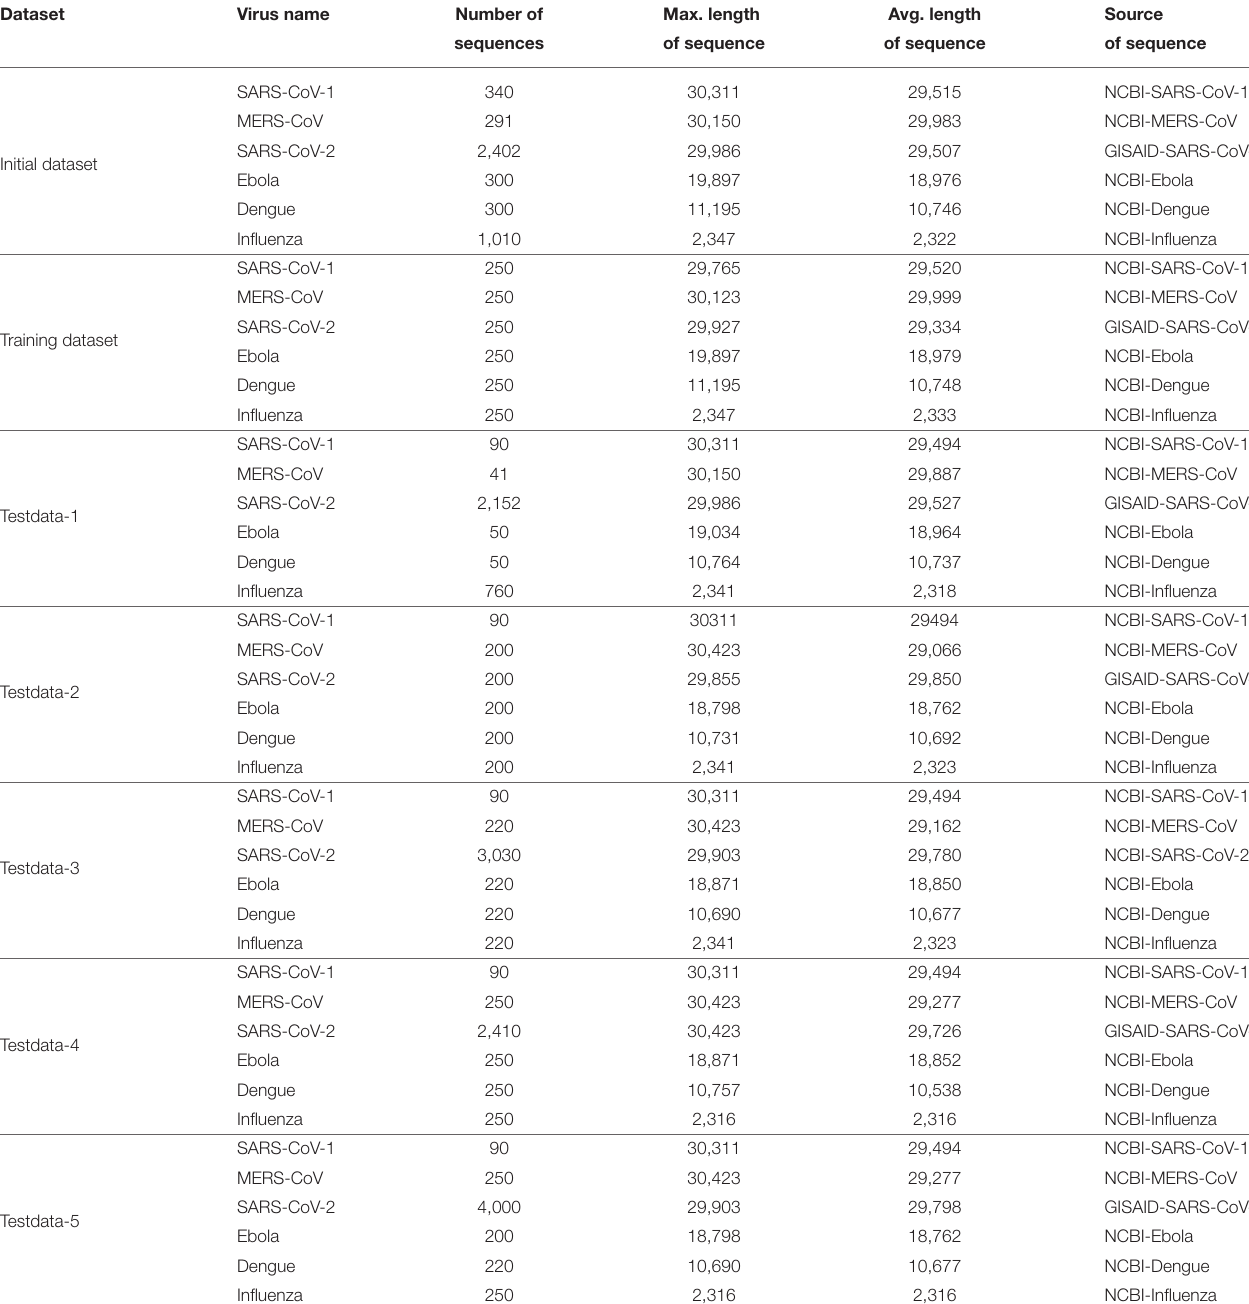
TABLE 1 | Description of initial, training, and test datasets.